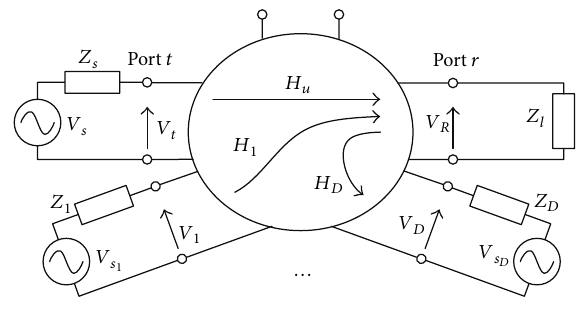
Figure 1: Equivalent model of the power delivery network.